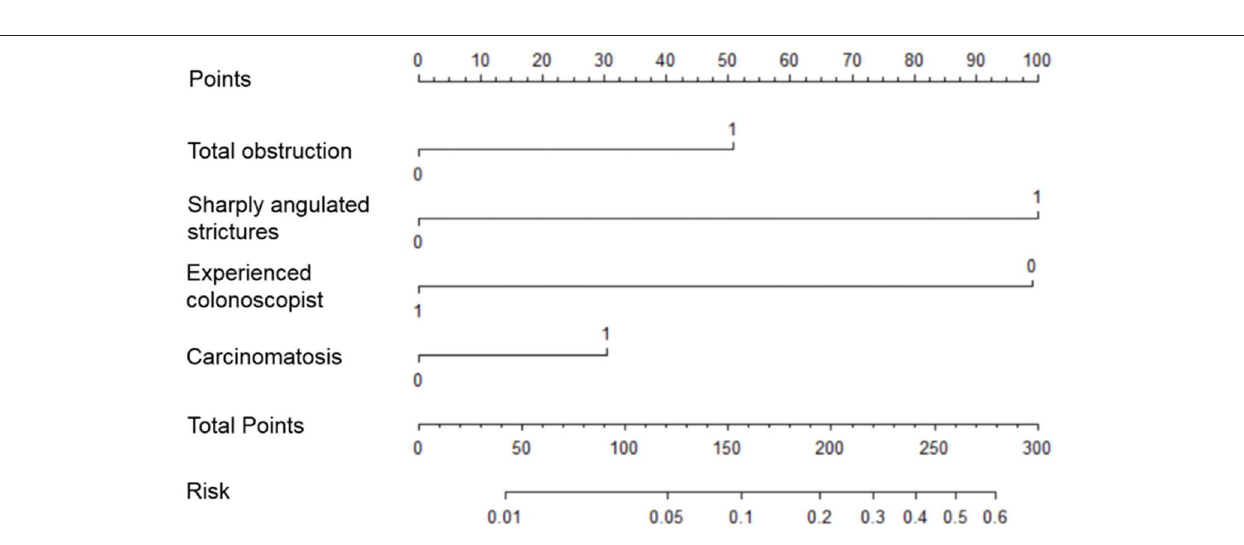
FIGURE 3 | Predictive nomogram for guidewire insertion